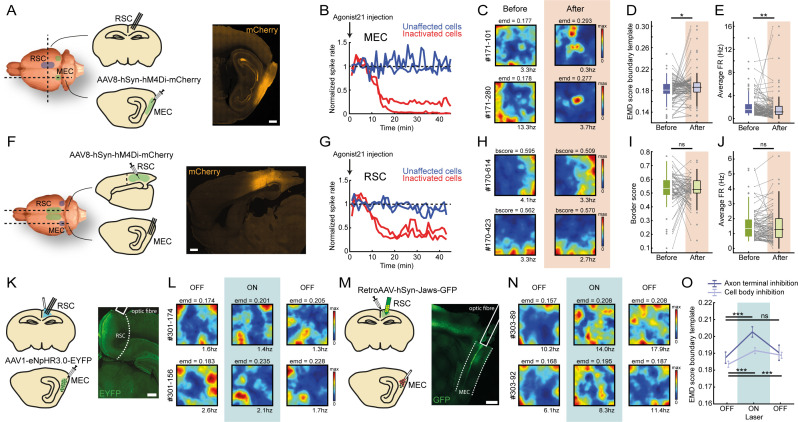
Sharp boundary tuning of RSC border cells relies on input from MEC.(A) An AAV encoding inhibitory DREADDs hM4Di was injected into MEC while tetrodes were positioned in RSC. Scale bar, 1 mm. (B) Four tetrodes were placed locally near the virus injection site, showing a subset of affected MEC neurons that decreased their activity 10–15 min after subcutaneous administration of agonist-21 (DREADDs agonist). (C) Two example RSC border cells that were affected by MEC inhibition and lost their spatial tuning. (D-E) Border cells in RSC exhibited increased EMD scores as well as lower firing rates after inhibition of MEC. Gray lines indicate individual cells. (F) Reversed experiment, with electrophysiological recordings in MEC while the AAV was injected into RSC. Scale bar, 1 mm. (G) A subset of RSC neurons decreased their activity after the administration of agonist-21. (H) Two example MEC border cells that were unaffected by inhibition of RSC. (I-J) Border cells in MEC did not show any significant qualitative changes in border tuning or firing rates after RSC inhibition. Gray lines indicate individual cells. (K) An AAV encoding inhibitory Halorhodopsin channels was injected into MEC, while an optrode with tetrodes and optic fiber was implanted in RSC to inhibit MEC axons. Scale bar, 1 mm. (L) Two example border cells in RSC that showed disrupted border tuning during inhibition of MEC terminals near the recording site. (M) A retroAAV encoding red-shifted inhibitory Cruxhalorhodopsin (Jaws) channels was injected into RSC together with the implantation of a 64-channel silicon-probe, while an optic fiber was placed at the dorsal edge of MEC for the silencing of cells that project to RSC. Histology shows the expression of the virus in neurons located in deep layers of MEC. Scale bar, 1 mm. (N) Two examples of RSC border cells that were disrupted due to optogenetic silencing of RSC-projecting neurons in MEC. (O) RSC border cells showed disrupted border tuning on a population-level as a direct result of MEC inhibition, both when silencing RSC-projecting neurons in MEC as well as during local inhibition of their axon terminals near the recording sites in RSC. *p<0.05, **p<0.01, ***p<0.001, Wilcoxon signed-rank test.